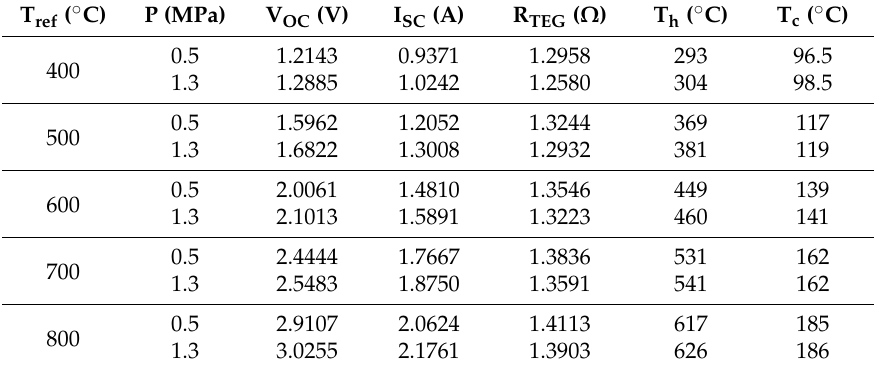
Parameter characterization ( V OC —open-circuit voltage, I SC —short-circuit current, R TEG —TEG resistance, T h —temperature at TEG hot surface, T c —temperature at TEG hot surface) at different temperature references for the heater (400 ˝ C, 500 ˝ C, 600 ˝ C, 700 ˝ C and 800 ˝ C), each for the two pressure values (0.5 MPa and 1.3 MPa).